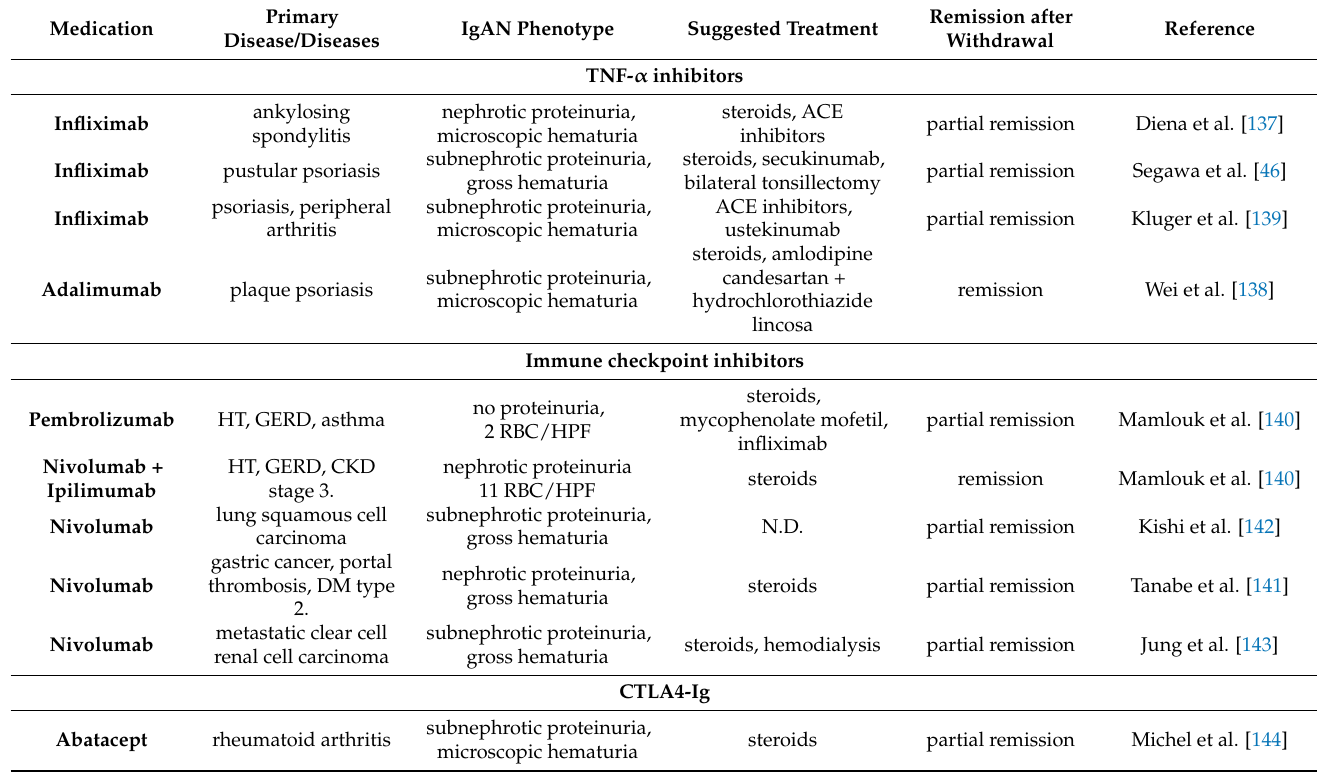
Table 2. Summary of literature concerning drug-induced IgA